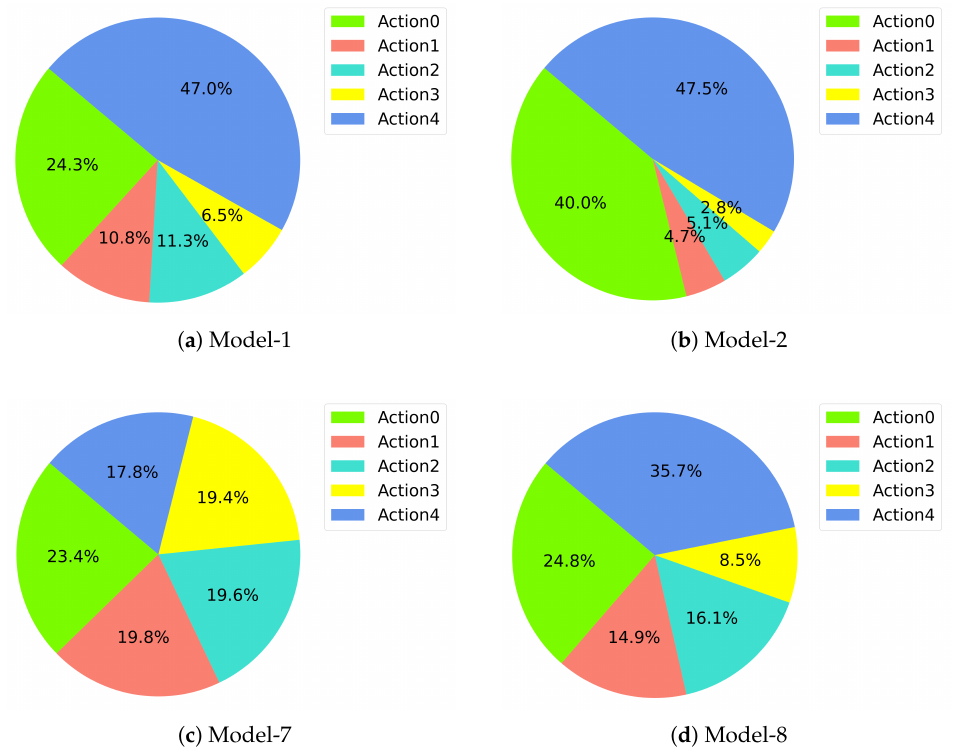
Figure 12. Action Frequencies.